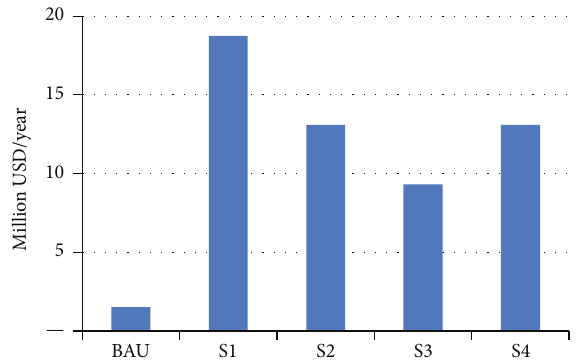
Figure 10: Investment for wastewater treatment